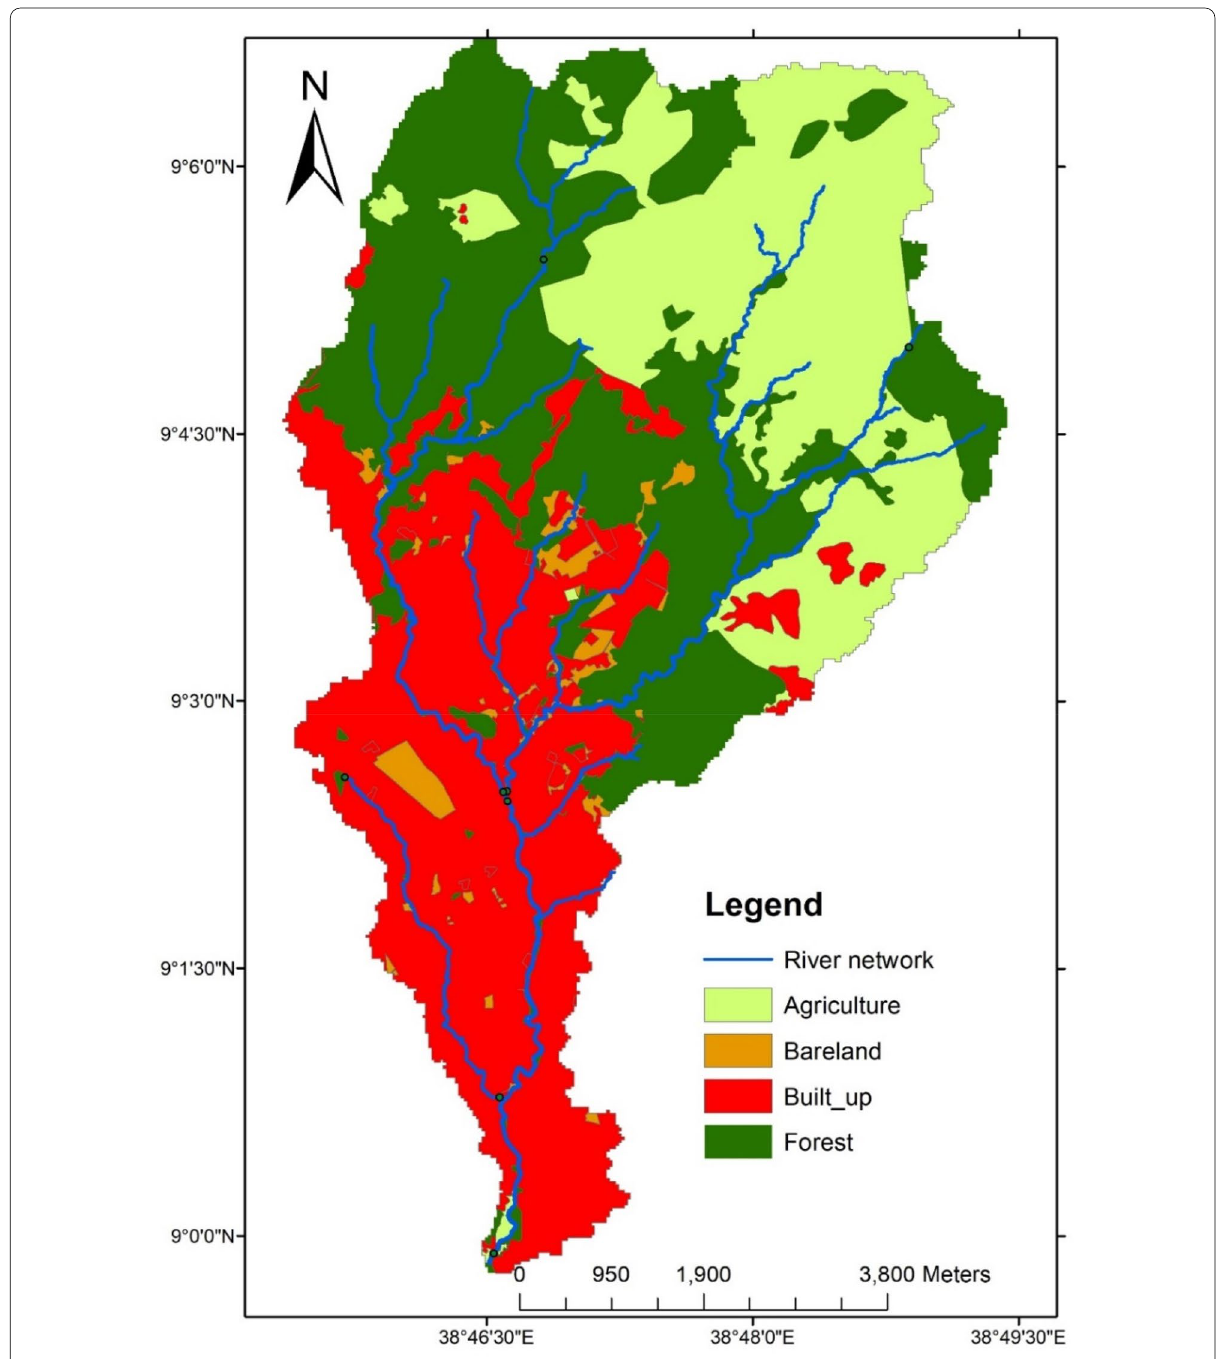
Fig. 4 Map of Land Use types of the catchments within the Kebena River